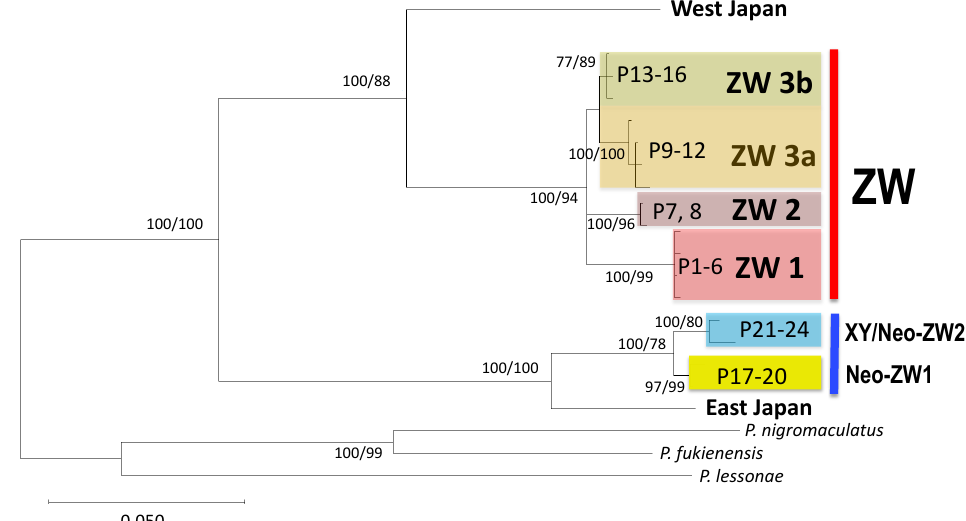
Figure 2. Bayesian tree based on 918 bp partial sequences of mitochondrial cytochrome b . Numbers at each node are bootstrap probability calculated by maximum likelihood method and Bayesian posterior probability by Bayesian